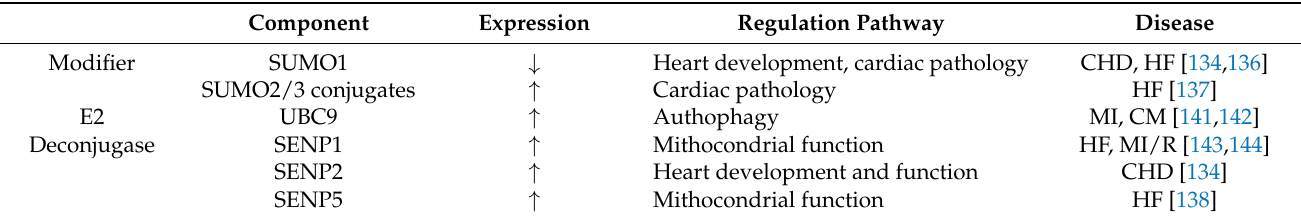
Table 8. Heart disease related SUMO